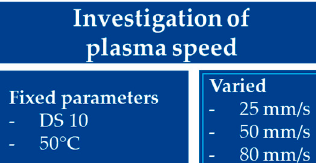
Figure 7. Fixed and varied process parameters for the investigation of plasma speed.